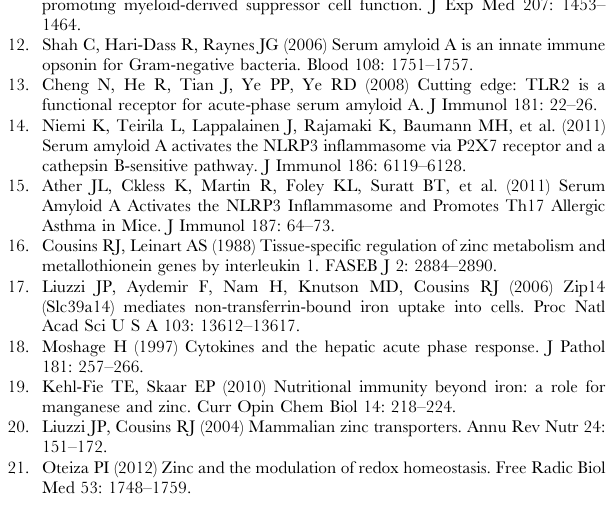
Figure S1 Genomic analysis of mouse lung transcrip- tome in the combinational setting of CLP-induced sepsis and Zn status. ( A ) The flow chart illustrates the experimental procedure: C57/B6 mice were administered a control diet (Ctrl), Zn-deficient (Zn-) diet, or a Zn-deficient diet for 18 days followed by oral Zn-supplementation (Zn + ) diet for 3 more days. The three week dietary regimes were then followed by CLP and tissue harvest at 24 hrs post CLP and then microarray analysis. ( B ) A volcano plot is shown to illustrate fold-change and corresponding significance in change (p-value) between CLP and non-CLP (Ctrl) groups. The cut-off boundary is shown as a red dash line. ( C ) The volcano plot demonstrates that Zn deficiency alone did not have a substantial global influence on gene expression. ( D ) The heatmap visualization of hierarchical clustering generated from the most significant changing genes induced by CLP. Figure S2 Network analysis of mouse lung transcrip- tome in the combinational setting of CLP-induced sepsis and Zn status. ( A ) Top signaling networks induced by CLP- mediated sepsis. ( B ) Top signaling networks generated from Zn- responsive genes by IPA. Figure S3 The effects of Zn deficiency (Zn-) on SAA1 production in response to IL-1 and IL-6 in HepG2 cells. HepG2 cells were cultured in the Zn-deficient medium for 7 days. Zn was removed from fetal bovine serum (FBS) by overnight